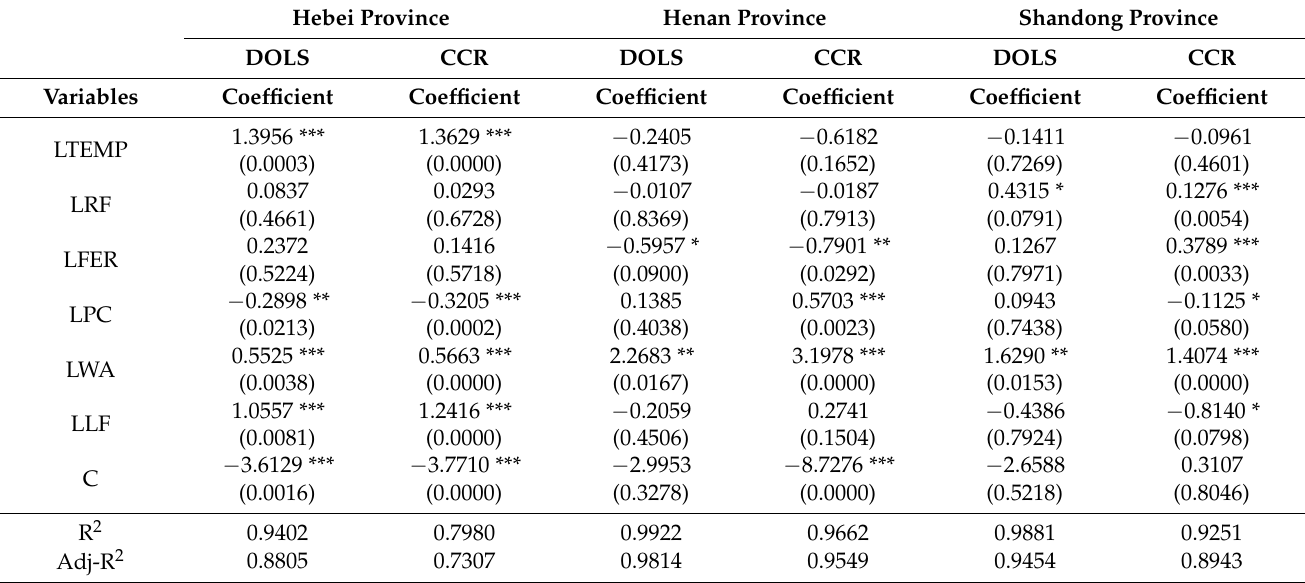
Table 5. Robustness